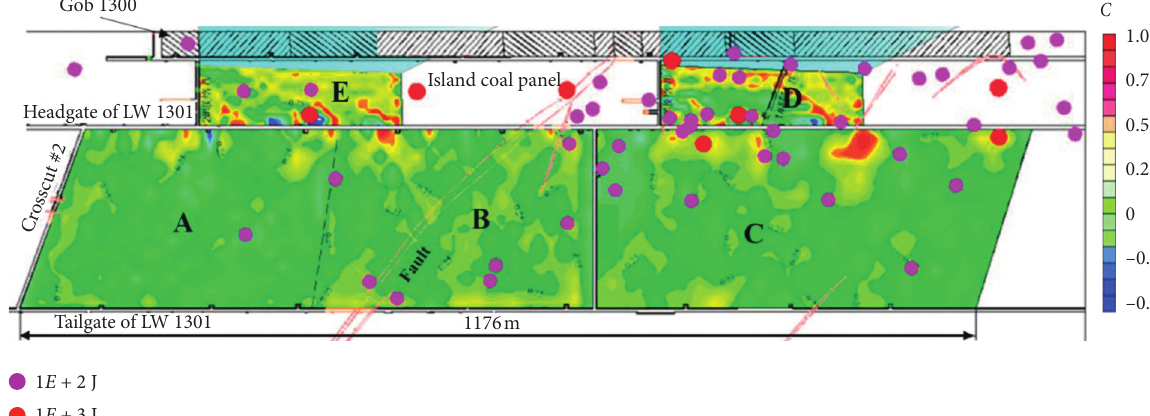
Figure 9: Distribution of microseismic events and rockburst risk indexes in LW 1301 and island coal